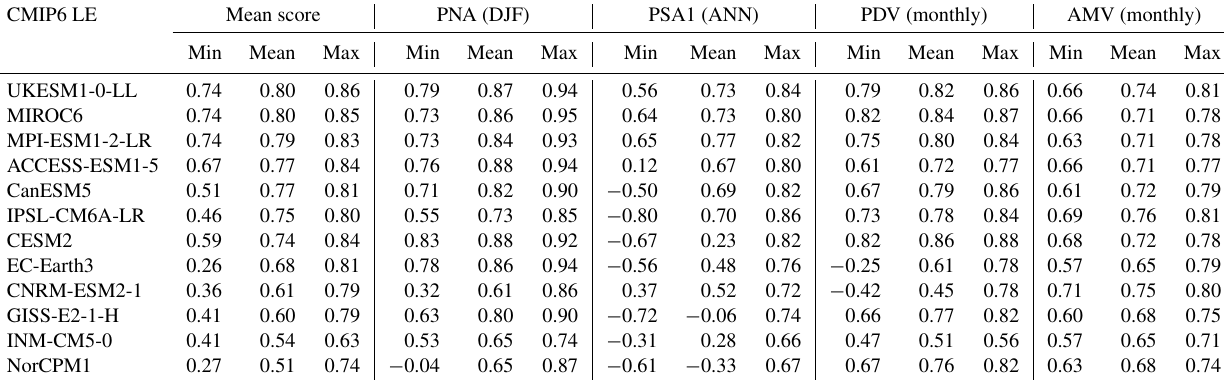
Table 2. Pearson r correlations between the simulated (CMIP6 LE) and observed (ERA20C_ERA5, ERSSTv5) spatial patterns of PNA, PSA1, PDV and AMV over the 1900–2014 period. Models are sorted according to the average mean score (column in bold; descending order). CMIP6